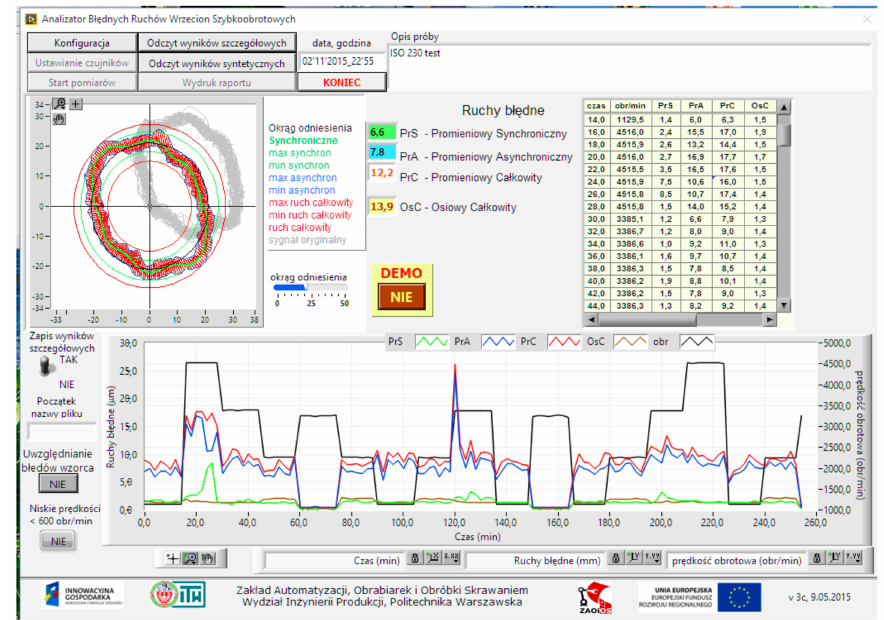
Figure 67. View of the ABRWS start screen.